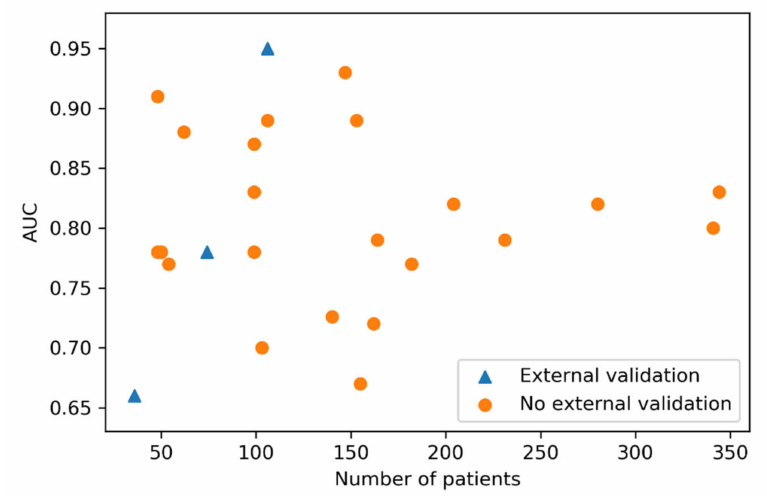
Figure 3. Scatter plot showing number of patients included per study and the performance reported. The studies with a blue triangle were externally validated and studies marked with an orange circle were tested internally.